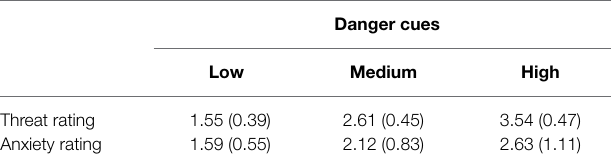
TABLE 2 | Mean ratings for threat and anxiety at three levels of danger